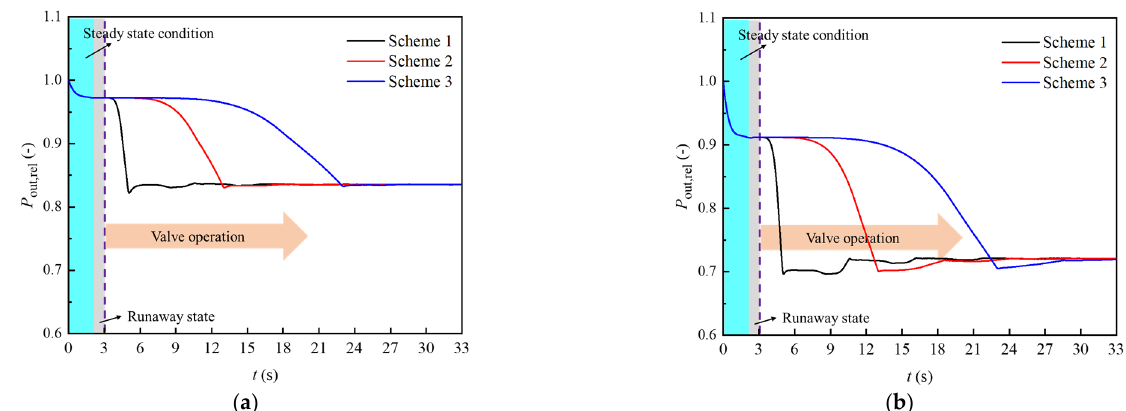
Figure 18. Variation law of the return water pressure under different valve opening schemes. ( a ) 0.85 Q BEP . ( b ) 1.1 Q BEP .